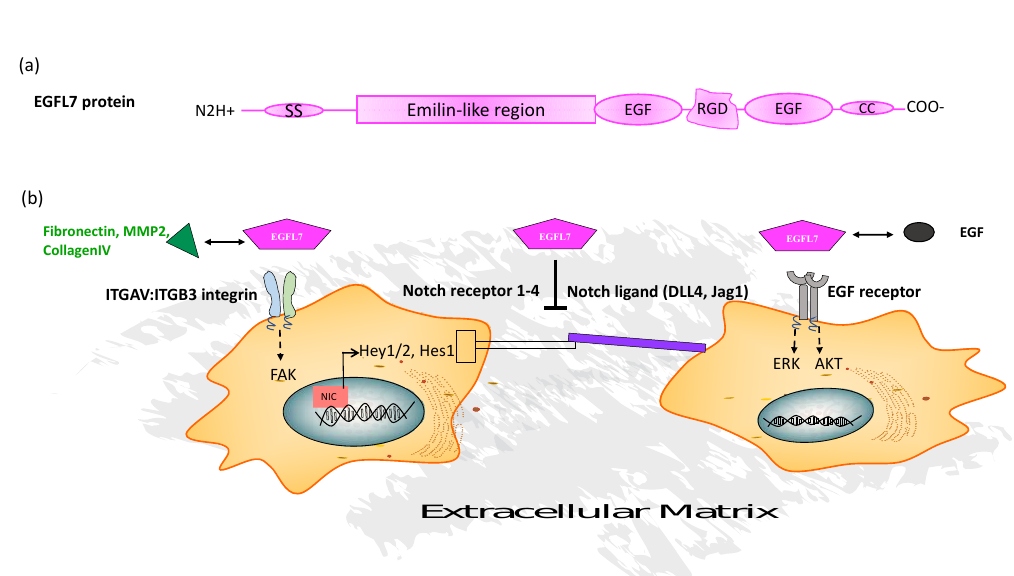
Figure 1. ( a ) Model structure of the EGFL7 protein. EGFL7 contains two EGF-like repeats: an arg-gly-asp integrin-binding motif (RGD) and an Emilin-like region. ( b ) The regulatory network of EGLF7. EGFL7 binds via its RGD domain to ITGAV:ITGB3 integrin and causes among others FAK autophosphorylation. EGFL7 competes for binding to the integrin with the ECM molecules fibronectin, MMP2, and collagen IV. The Emilin-like region of EGFL7 interacts with Notch receptor 1 – 4 and Notch ligands DLL4 and Jag1 and suppresses Notch signaling, resulting in impaired NIC translocation into the nucleus and reduced Hey1/2 and Hes1 transcription. EGFL7 binding to EGFR results in the activation of the signaling pathways extracellular signal-regulated kinase (ERK) and AKT, among others. EGFL7 competes for binding to EGFR with EGF. Abbreviations: EGF, epidermal growth factor; EGFL7, epidermal growth factor-like protein 7; EGFR, epidermal growth factor receptor; ERK, extracellular signal-regulated kinase; FAK, focal adhesion kinase); MMP2, matrix metalloproteinase 2; DLL4, delta like-protein 4; Jag1, Jagged1; NIC, Notch intracellular domain; ECM, extracellular matrix.